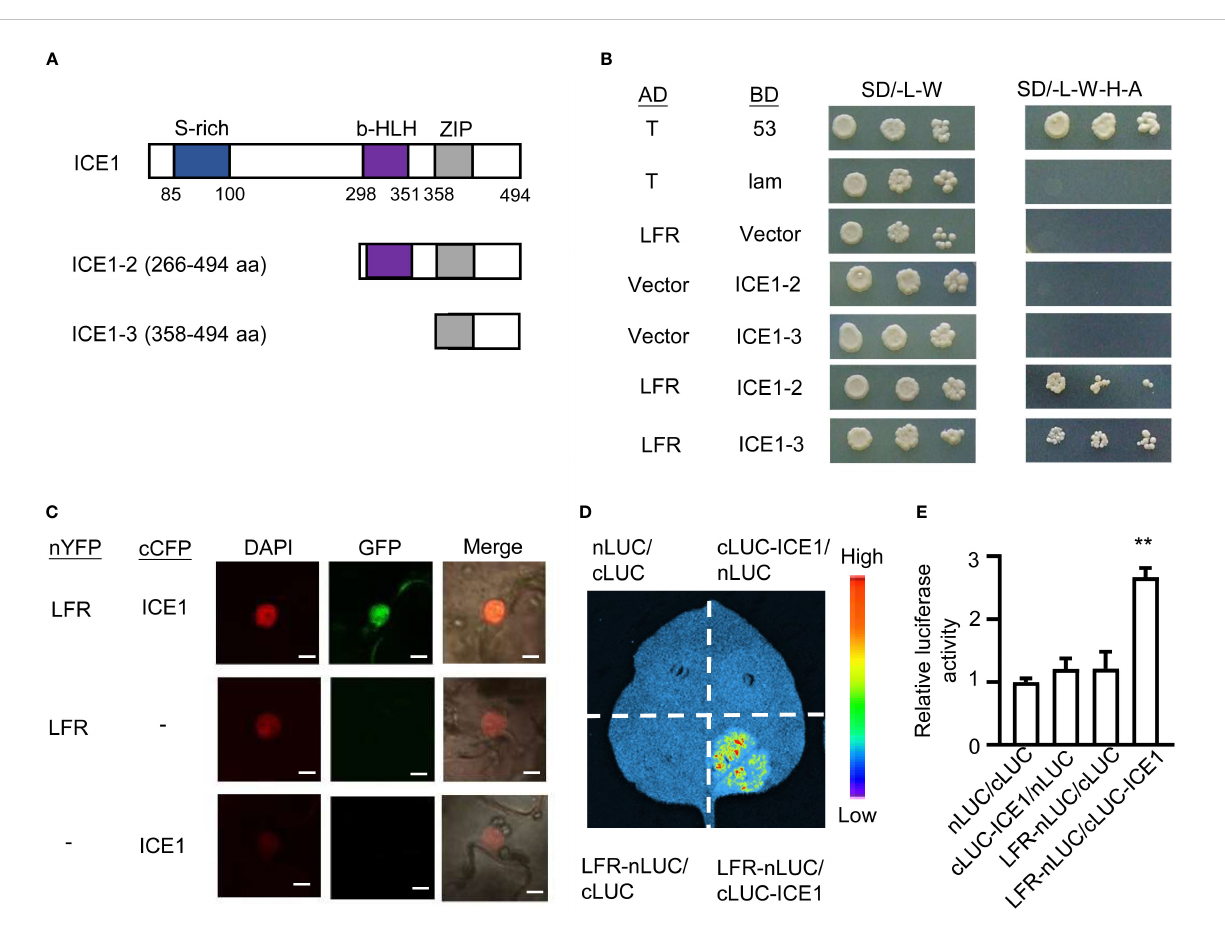
FIGURE 3 The interaction of LFR with ICE1. (A) Diagrams of the truncated ICE1 proteins used in the Y2H assays shown in (B) . ICE1-2 and ICE1-3 include the bHLH and ZIP (amino acids 298 – 494) and ZIP domains (amino acids 358 – 494), respectively. (B) LFR interacted with ICE1 in the Y2H assay. The assays were carried out using AH109 yeast cells co-transformed with the indicated plasmid pairs (serially diluted 10 -1 , 10 -2 , and 10 -3 ) on synthetic de fi ned medium lacking Ade, His, Leu, and Trp (SD/-L-W-H-A). AD-T/BD-53 and AD-T/BD-Lam were used as positive and negative controls, respectively. (C) nYFP-LFR interacted with cCFP-ICE1 in a BiFC assay carried out in transiently transformed tobacco leaf epidermal cells. Leaves co- transformed with nYFP-LFR/cCFP or nYFP/cCFP-ICE1 served as a negative control. DAPI and GFP fl uorescence indicate the nucleus and protein interaction, respectively. Merge corresponds to an overlay of the DAPI and GFP signals. Bar =5 m m. (D) LCI assays were used to test for the interaction of LFR with ICE1 in transiently transformed tobacco leaf epidermal cells. Light emission was observed from tobacco leaves co-expressing LFR-nLUC/cLUC-ICE1, but not from leaves co-expressing the negative controls (LFR-nLUC/cLUC or cLUC-ICE1/nLUC or cLUC/nLUC). (E) The Relative luciferase activity of LCI assay in (D) . Error bars indicate the SD of four biological replicates. Statistically signi fi cant differences from the nLUC/cLUC control are indicated by asterisks (**P < 0.01, Student ’ s t